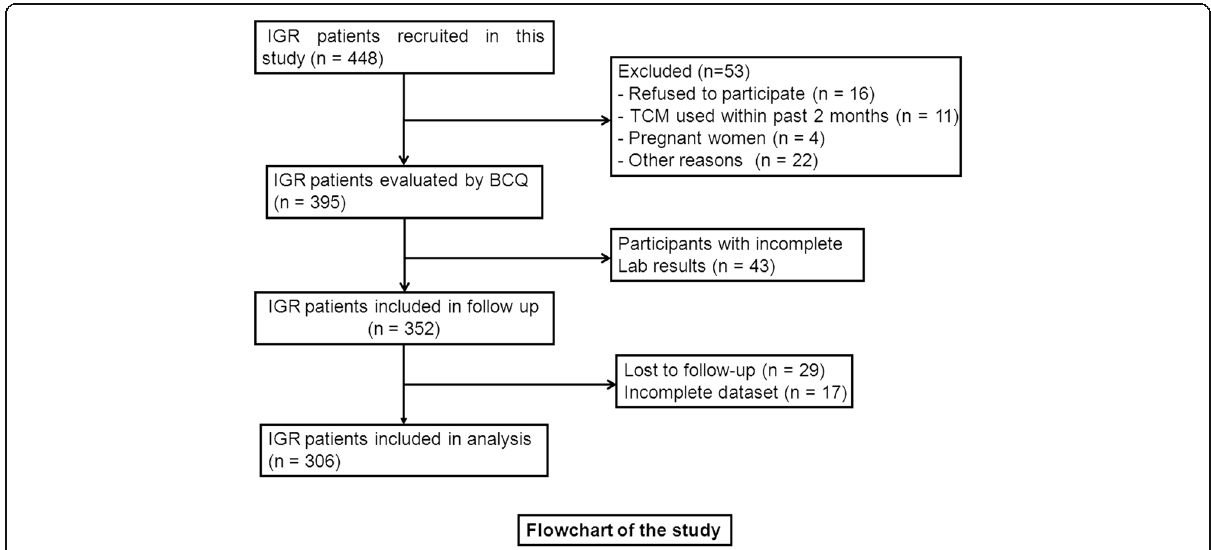
Fig. 1 The recruitment flowchart of the study participants. A total of 448 participants with IGR were recruited in the study, 395 cases were evaluated by BCQ for their TCM body constitutions, 352 cases were performed follow-up, and 306 cases were included in the final